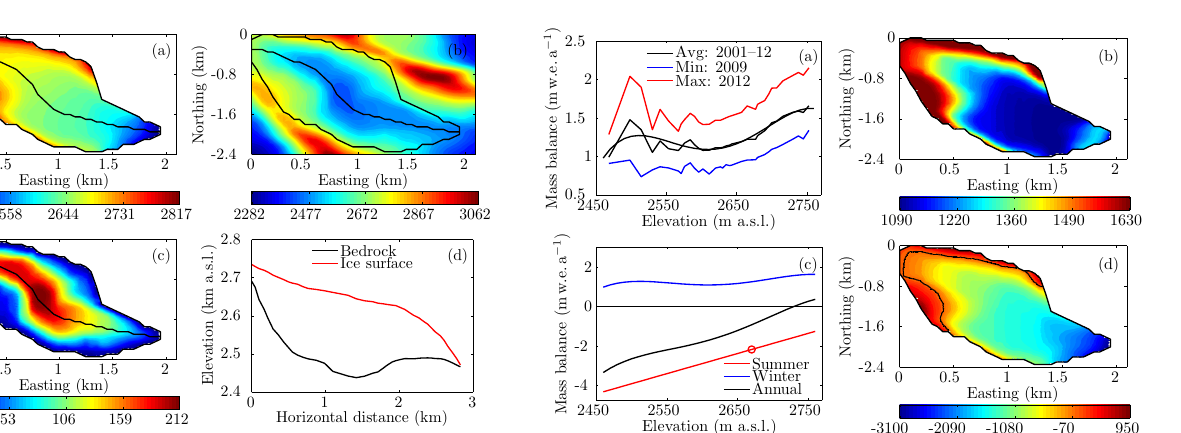
Fig. 3. Present-day surface mass balance of Haig Glacier. (a) Win- ter (September to May) snow water equivalent profiles as a func- tion of glacier surface elevation. Minimum and maximum balances were measured in 2009 and 2012, respectively. The dashed line corresponds to a fourth-order polynomial fit to the mean profile (average of 2001–2012). (b) Distribution of winter mass balance (mmw.e.a − 1 ) over the present-day glacier domain. (c) Seasonal and annual surface mass balance profiles. The circle denotes the summer mass balance at the reference altitude, b s0 (Eq. 1). (d) Dis- tribution of net annual mass balance (mmw.e.a − 1 ). The black curve depicts the present-day equilibrium line